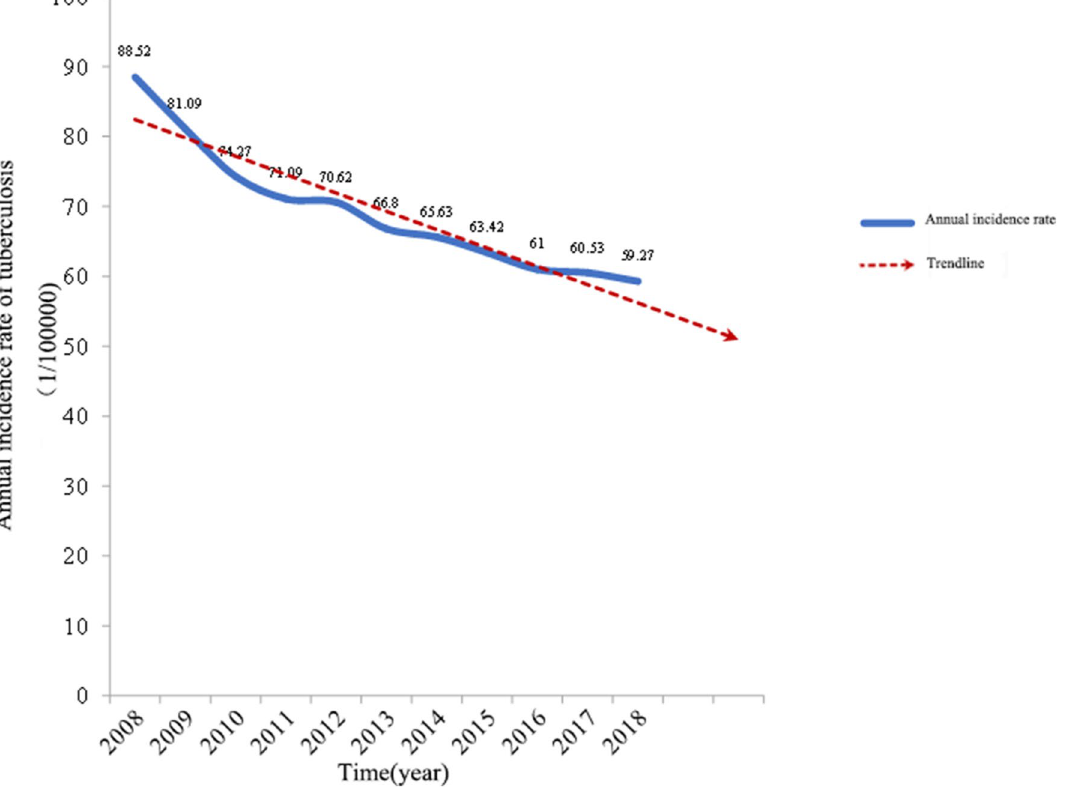
Figure 1. Statistics of annual incidence rate of tuberculosis in China from 2008 to